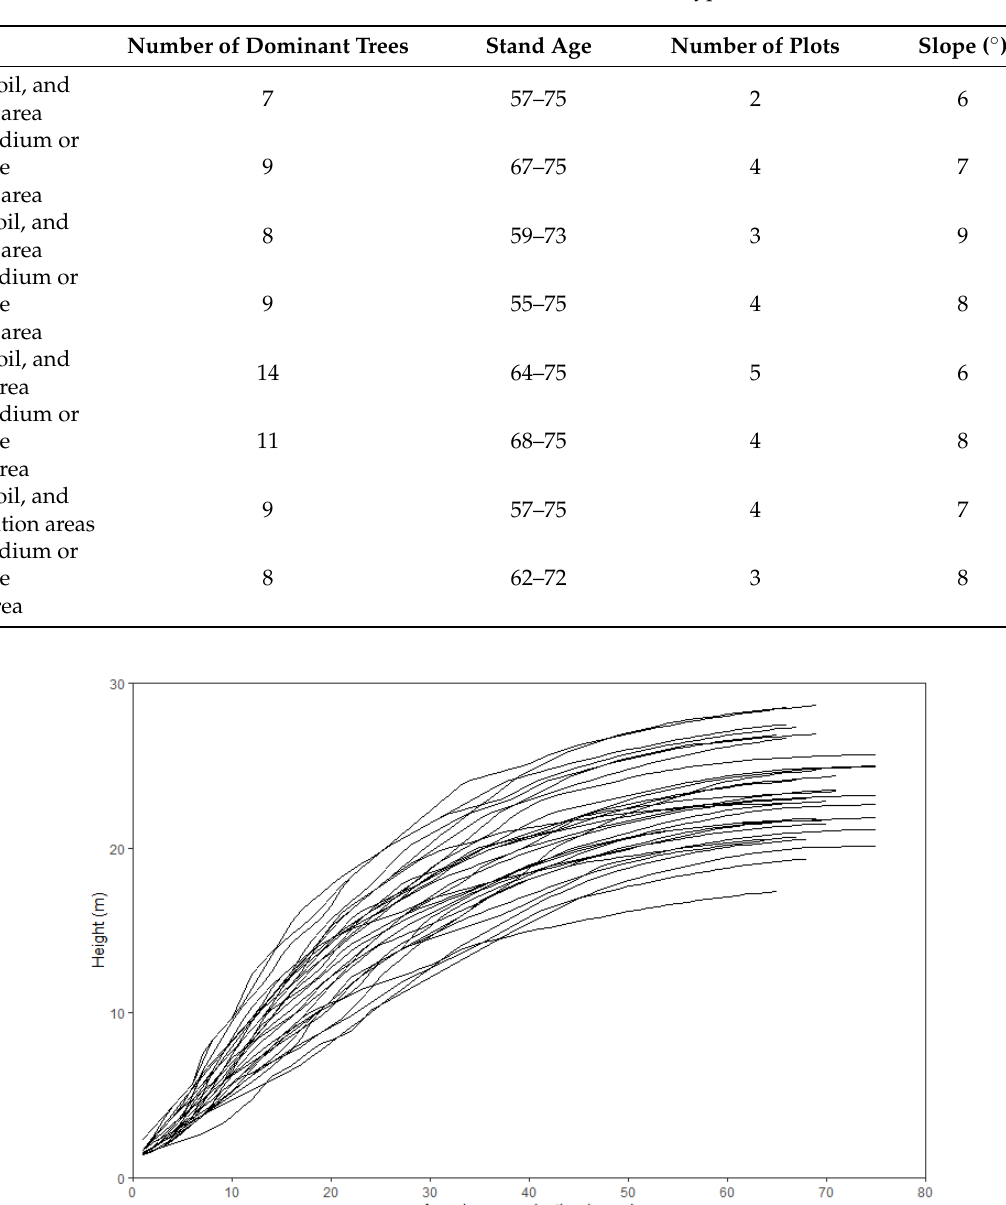
Table 1. Distribution of dominant larch trees in different site types.